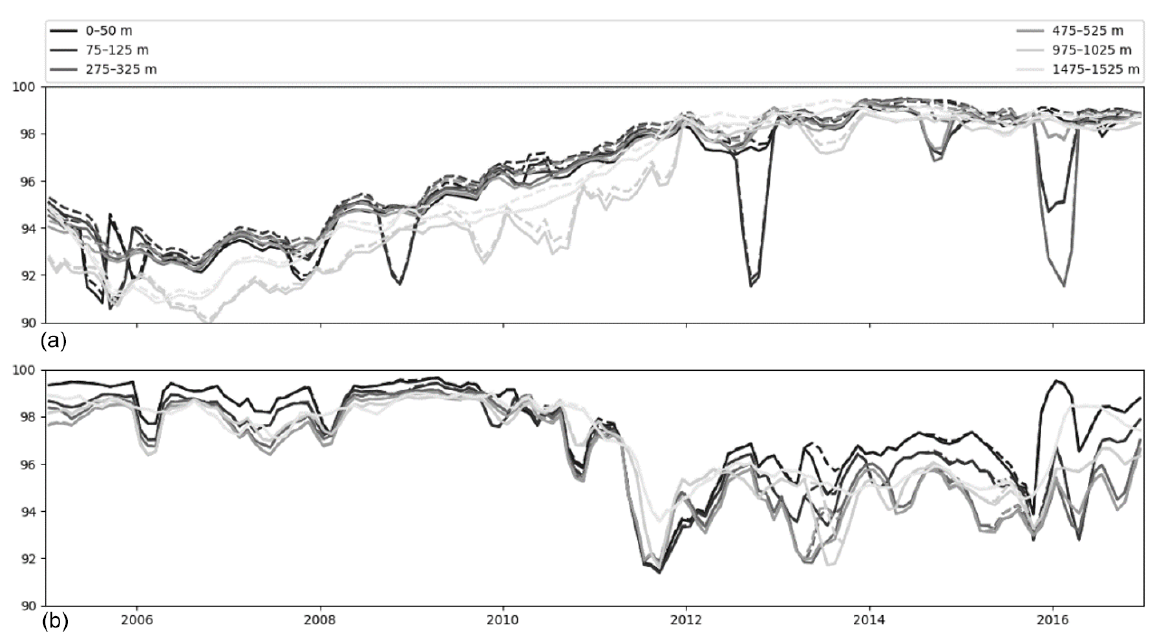
Figure 5. Coverage of the temperature (dashed line) and salinity (solid line) objective analysis.